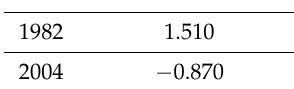
Figure 7. Northern Hemisphere Sea Ice Extent: ( a ) Detected peaks of Sea Ice Extent (Y axis) between 1953 and 2017 (X axis); ( b ) Identified inflection points of Sea Ice Extent (Y axis) between 1953 and 2017 (X axis). Positive inflection point (red diamond); negative inflection point (green diamond). Table 5. Positive and negative inflection points of Sea Ice Extent between 1953 and 2017. Positive Inflection Points